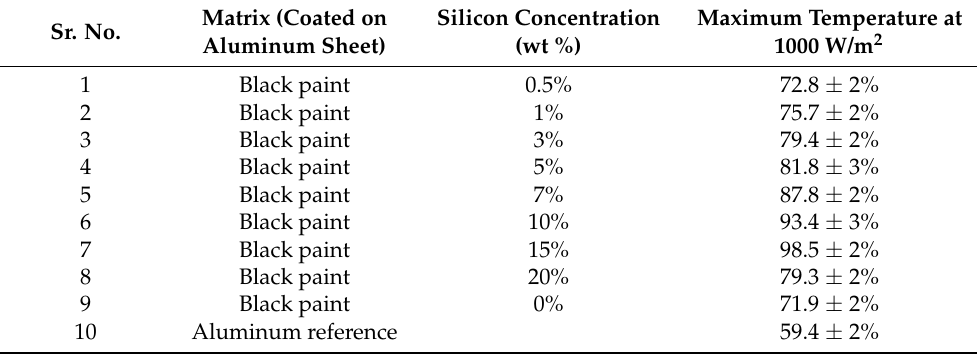
Table 2. Summary of the maximum observed temperature on the absorber surface vs. concentration in indoor